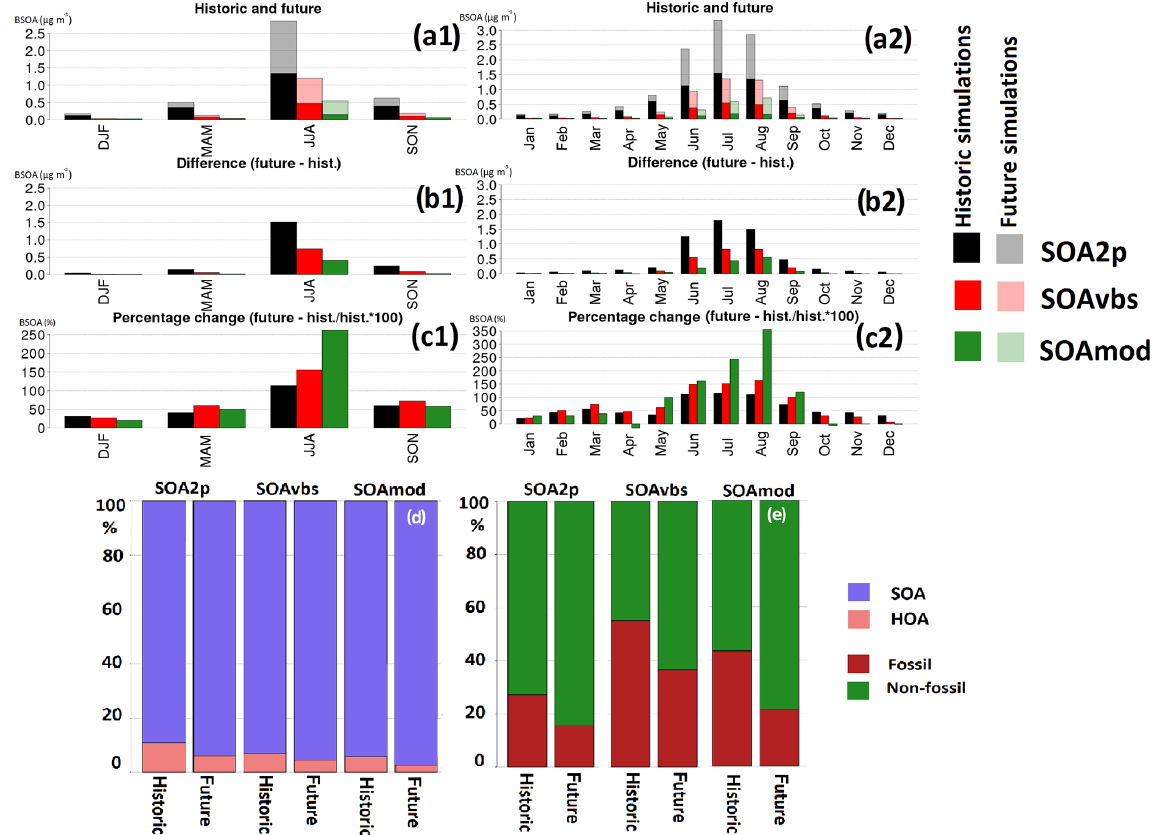
Figure 4. Seasonal and monthly averaged concentrations of BSOA for five years of simulations, and the oxidation state and origins of OA for the European sub-domain. (a1, a2) Historic simulations. (b1, b2) Absolute changes in future scenarios compared to historic simulations (future–historic). (c1, c2) Relative changes in future scenarios; (d, e) oxidation state and origins respectively. Lighter colors show future scenarios, and darker colors the historic